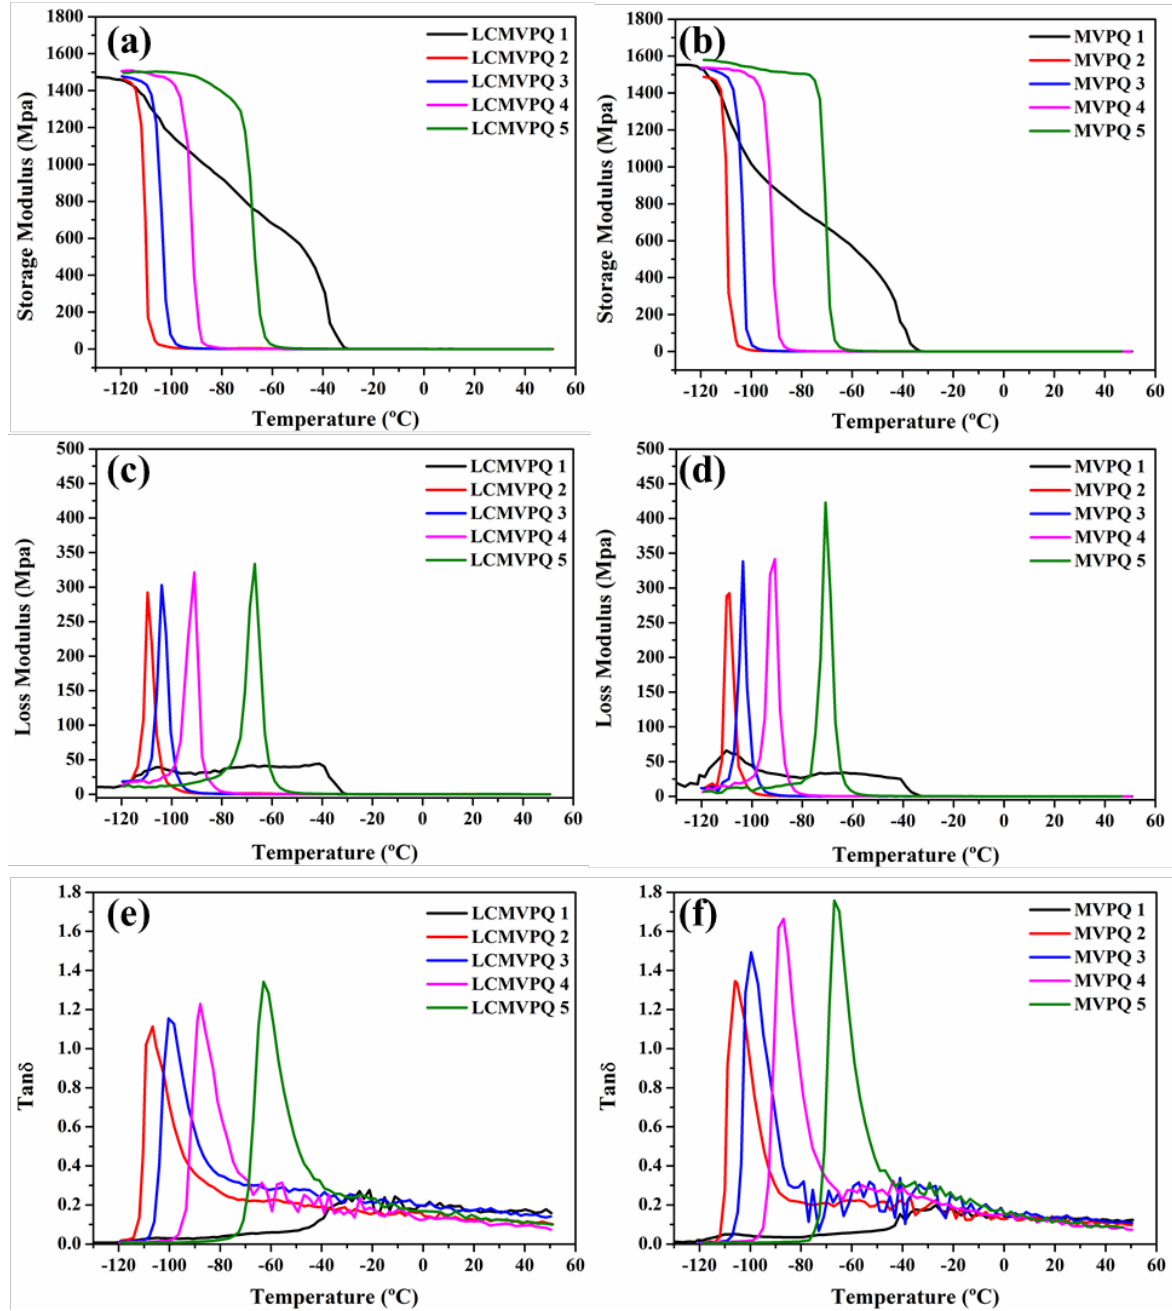
Figure 6. Storage modulus curves of ( a ) LCMVPQ 1-5 and ( b ) MVPQ 1-5; loss modulus curves of ( c ) LCMVPQ 1-5 and ( d ) MVPQ 1-5; and loss factor curves of ( e ) LCMVPQ 1-5 and ( f ) MVPQ 1-5.